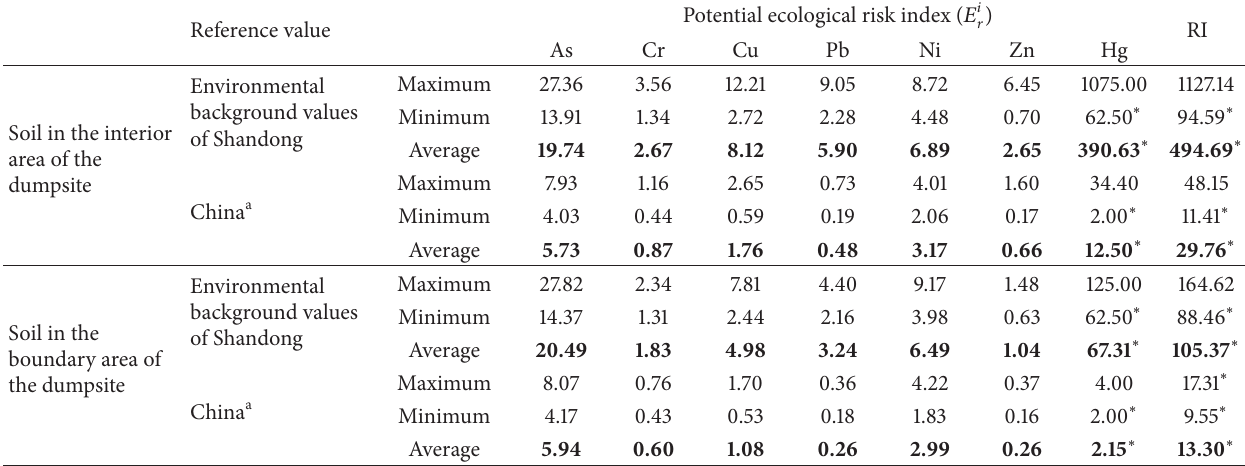
Table 6: Potential ecological risk indices ( 𝐸 𝑖 𝑟 , RI) of heavy metals in the